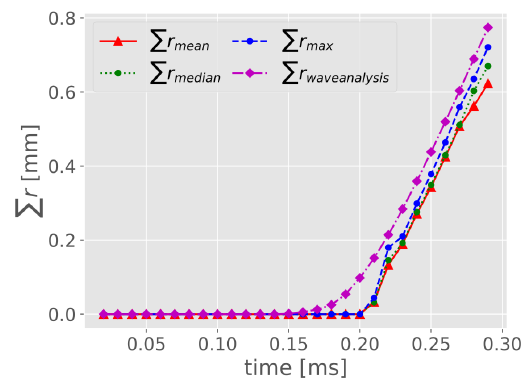
Figure 14. Diagram of the sum of crack widths.